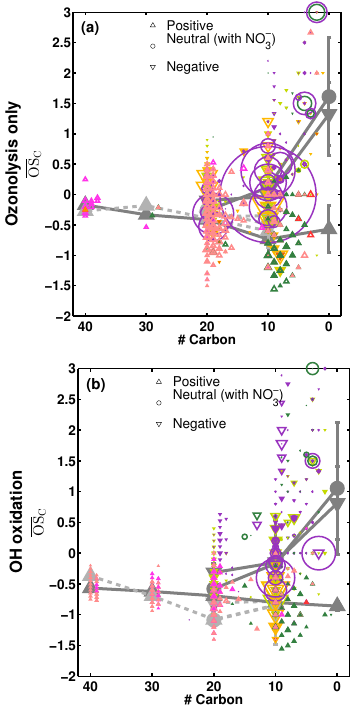
Figure 3. Mean carbon oxidation state (OS C ) for pure ozonolysis (a) and OH oxidation (b) as a function of the number of carbons for each identified oxidised organic compound in clusters for all three instruments. The shape of the markers indicate which type of clusters is depicted and the colors are the same as in Fig. 2. The weighted means and standard deviations for the various bands of positive and negative APi-TOF (C < 8, C = 8–12, C = 18–20, C = 28–30, and C = 38–40) are indicated with large gray symbols and bars. See main text for detailed discussion.